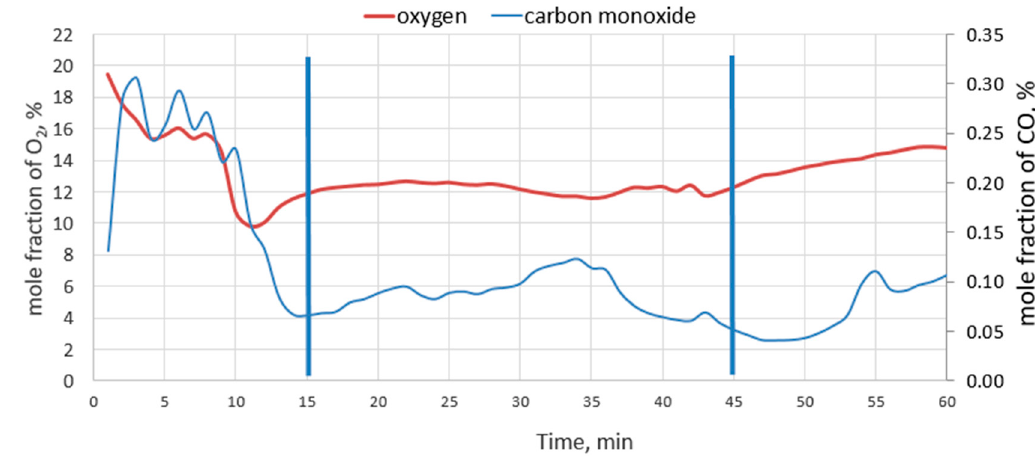
Figure 6. Vacuum in the combustion chamber and exhaust gas temperature during the full combustion cycle (Case 0).